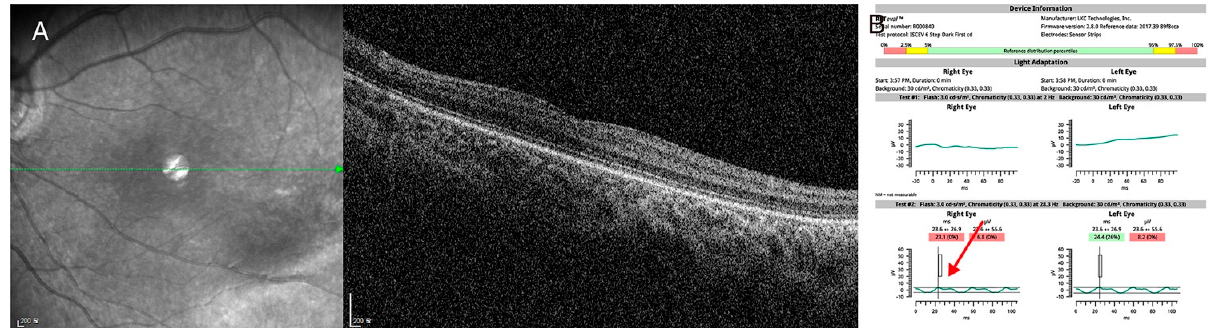
Figure 6. (P6) A case of dual diagnosis identified by targeted next-generation sequencing ( A ) Spectralis optical coherence tomography showed mild temporal retinal dragging with shallow fovea pit. ( B ) Hand-held electroretinogram showed severely attenuated light-adapted 3.0 response and reduced double peak in light-adapted 30Hz flicker response (red arrow), which was consistent with incomplete congenital stationary night blindness. Targeted next-generation sequencing showed the hemizygous c.1910+1G>A canonical splice site variant in CACNA1F gene and c.3833G>A:p.(Trp1278*) nonsense variant in LRP5 gene. Dual diagnosis of familial exudative vitreoretinopathy and incomplete congenital stationary night blindness was made in this patient, and regular monitoring of bone densitometry was recommended.